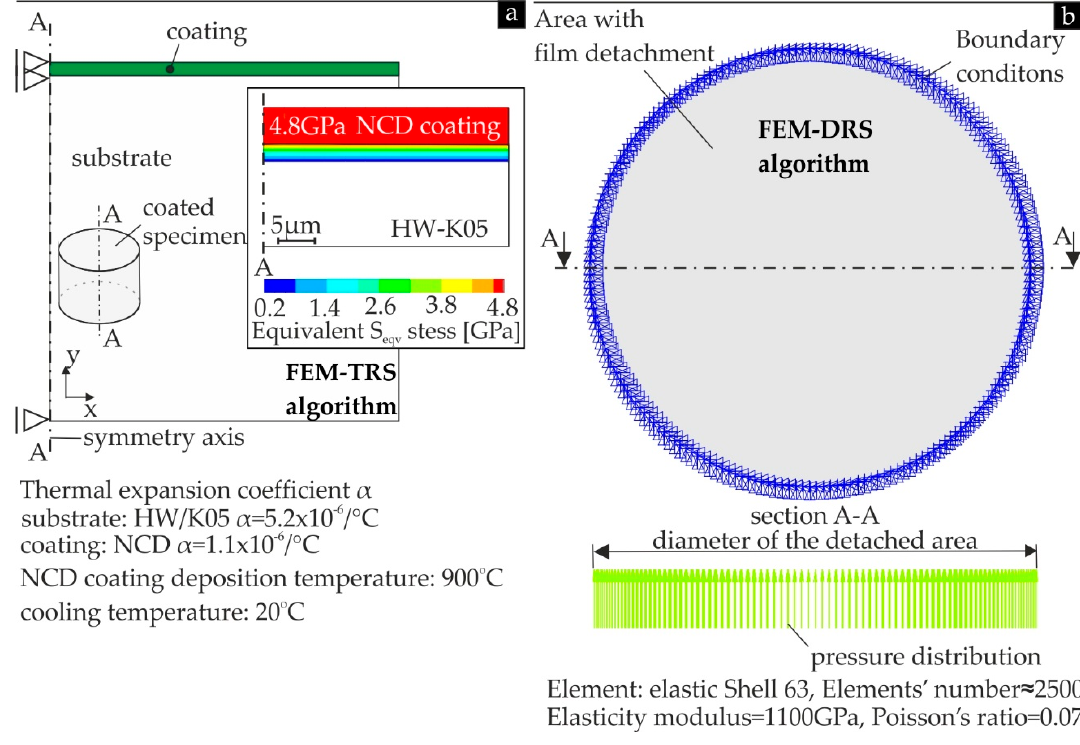
Figure 3. The applied finite element method (FEM) model for calculating ( a ) the thermal residual stresses and ( b ) the overall residual stresses in film structure after the diamond coating deposition and its annealing.